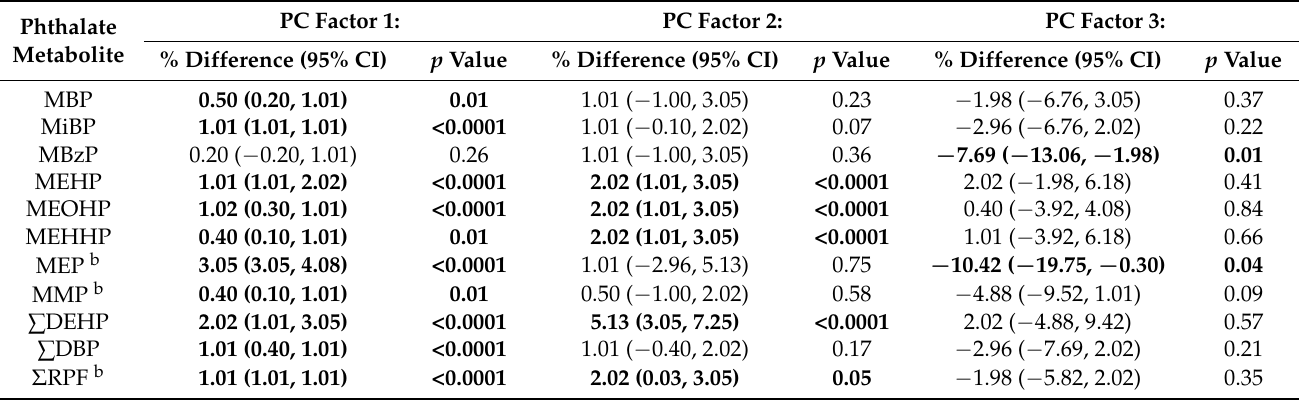
Table 3. Percent difference in specific gravity-adjusted urinary phthalate metabolites associated with principal components (PC) representing food and beverage consumption habits, among all pregnant women (n = 356) a .